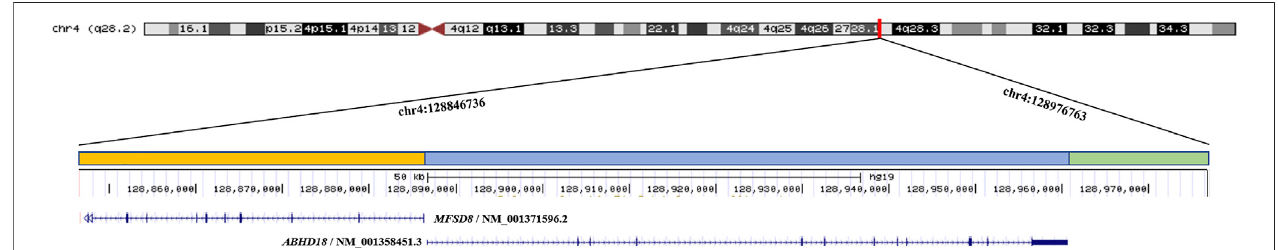
FIGURE 3 | The ~130 kb (chr4:128846736 - 128976763) deletion identi fi ed by CNV-seq extends from MFSD8 to ABHD18 at 4q28.2 in the proband. The orange bar represents the deletion region of MFSD8 , the blue bar represents the deletion region of ABHD18 , and the green bar indicates the deletion region without any known